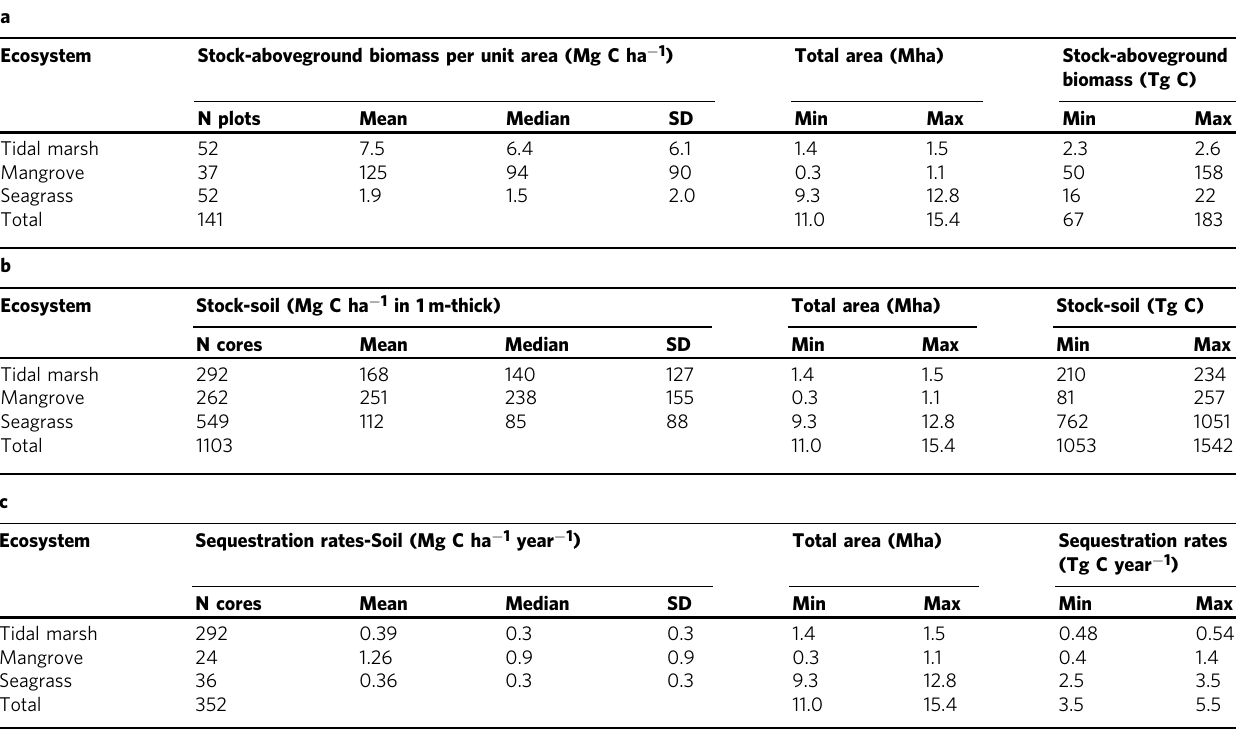
Table 1 Organic carbon (C) storage in Australian vegetated coastal ecosystems (i.e., tidal marshes, mangroves and